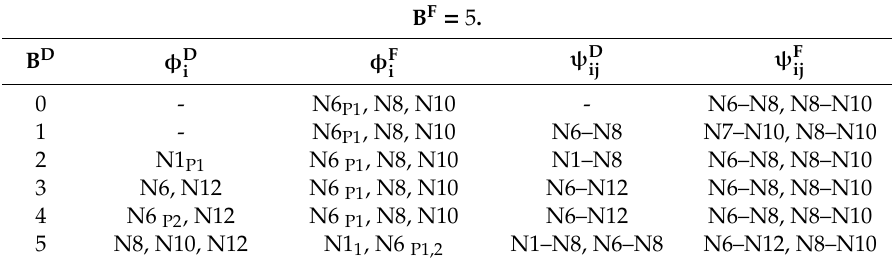
Table 2. Model behavior for di ff erent scenarios when the defender tried to use five deception resources and increases the protection budget. B F = 5 .